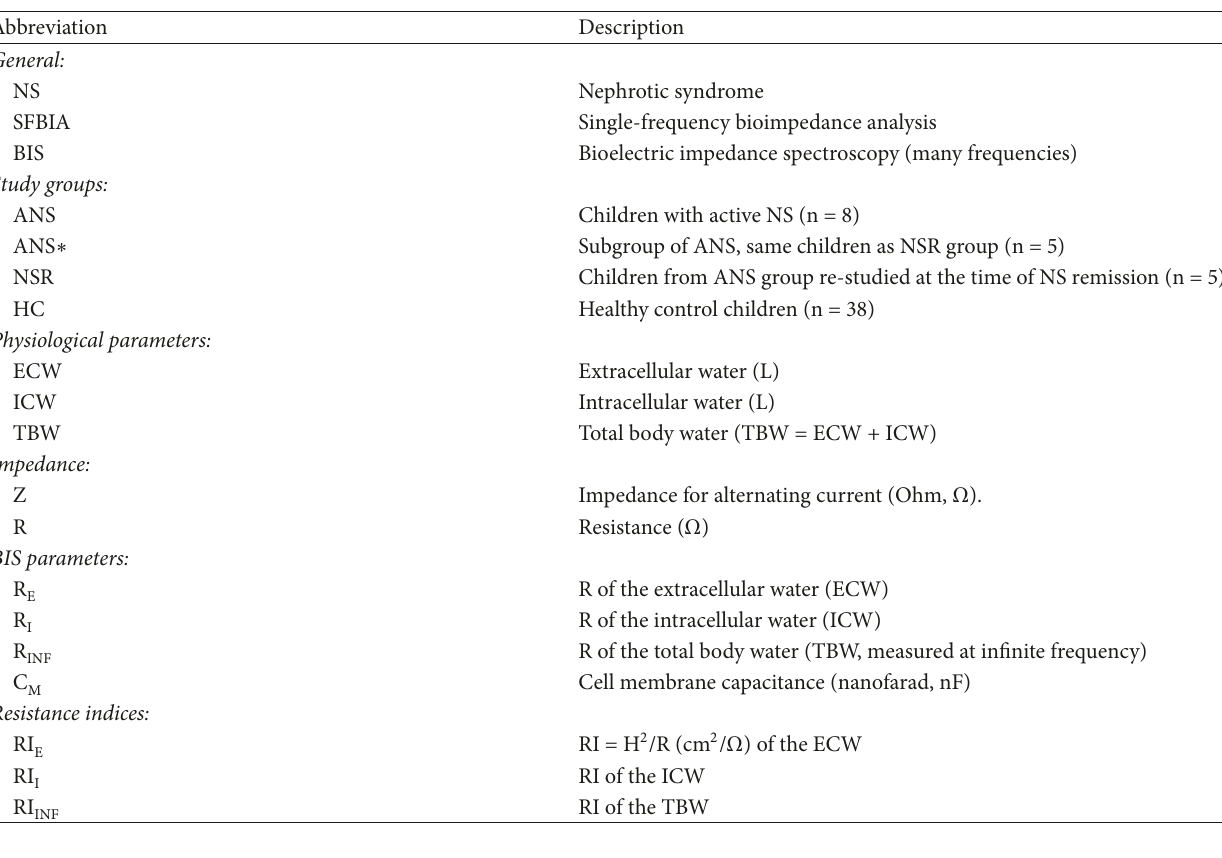
Table 1: Abbreviations and concepts used in this